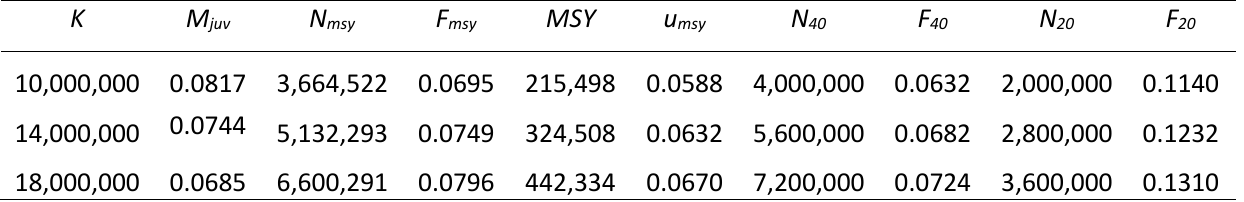
Table 50. Reference points for female horseshoe crab harvest in the Delaware Bay generated from a population projection model. Reference points were generated for a range of possible carrying capacities ( K ) and associated juvenile mortalities ( M juv ) needed to stabilize an unfished population at those carrying capacities.